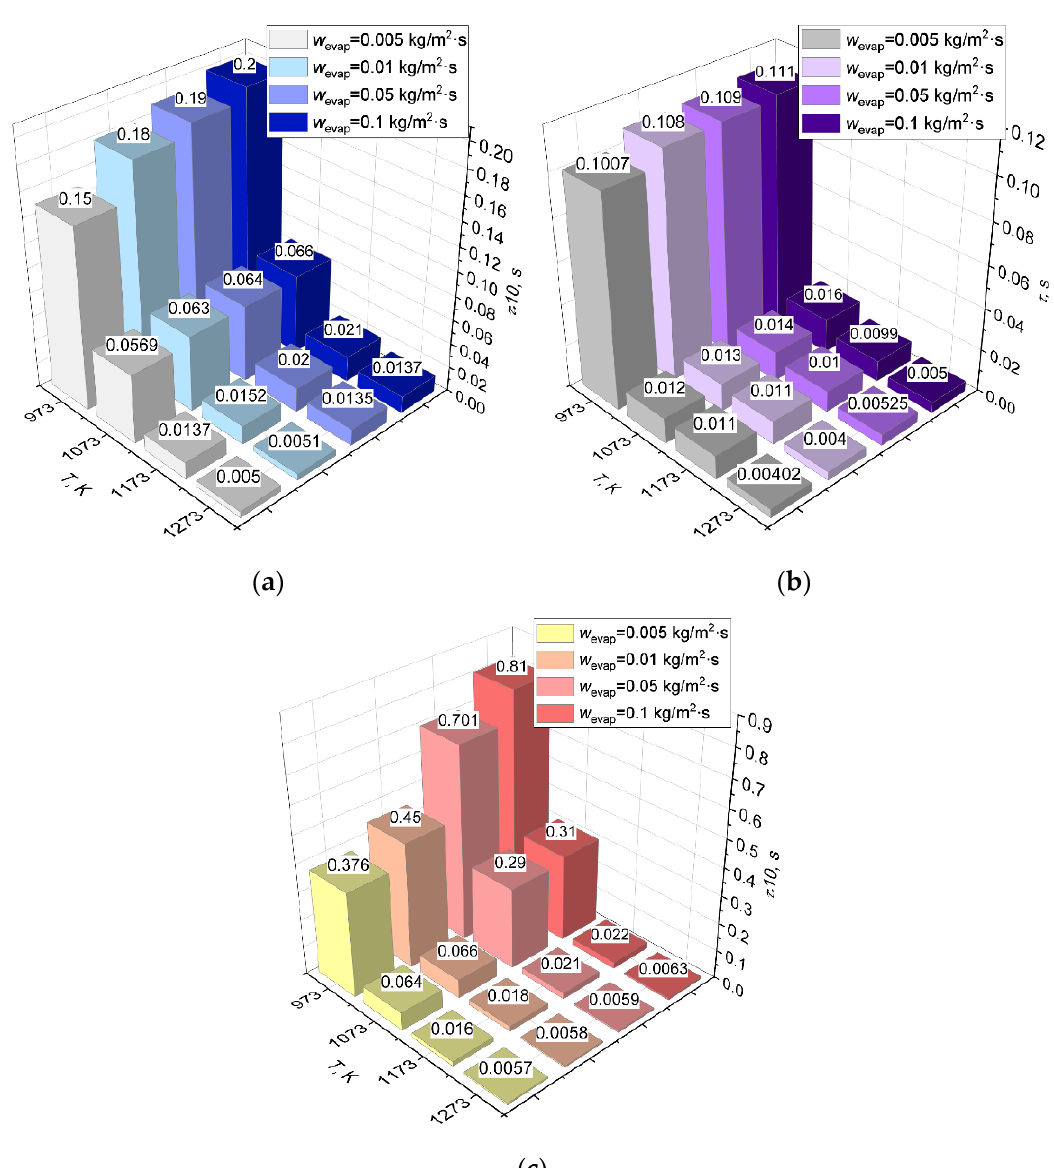
Figure 7. The gas hydrate ignition delay times ( R g = 0.5 mm) when varying the mass rate of water evaporation from the fuel sample surface and heating source temperature under the conditions of heat exchange: ( a ) radiant, ( b ) convective, ( с ) conductive.